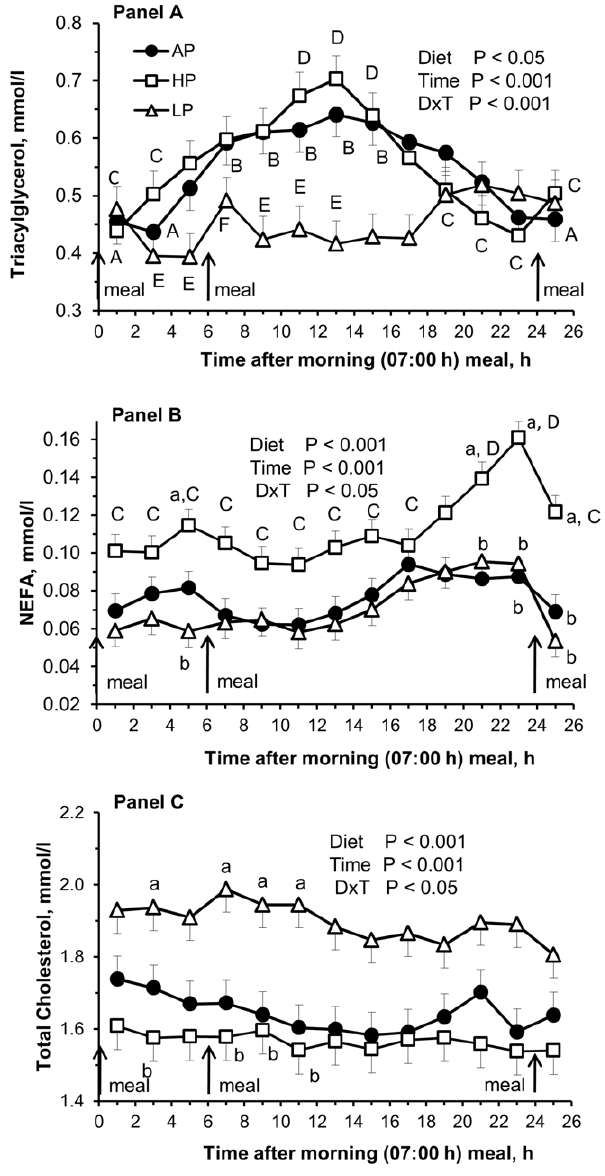
Figure 2. Diurnal plasma triacylglycerol, non-esterified fatty acid and total cholesterol concentrations at 92 dpc. Diurnal plasma metabolite concentrations of sows at 92 dpc fed isoenergetic diets with low protein:high carbohydrate (LP; open triangles), adequate protein:carbohydrate (AP; closed circles), and high protein:low carbo- hydrate (HP; open squares) ratios throughout pregnancy. Values are depicted from one hour after feeding the morning meal (50% of the daily allowance at 07:00h) to the midday meal (13:00 h) until the next day one hour after morning meal (08:00 h). Panel A, triacylglycerol; panel B, non-esterified fatty acids (NEFA); panel C, total cholesterol. Values are least square means 6 SE, n=9 per group. Inserts depict P values for the main factors diet and time and interactions. a,b,c Within time points, values with different lower case letters indicate significant differences ( P , 0.05) between diet groups. A,B Within diet AP, values with different upper case letters indicate differences ( P , 0.05) between time points. C,D Within diet HP, values with different upper case letters indicate differences ( P , 0.05) between time points. E,F Within diet LP, values with different upper case letters indicate differences ( P , 0.05) between time points.